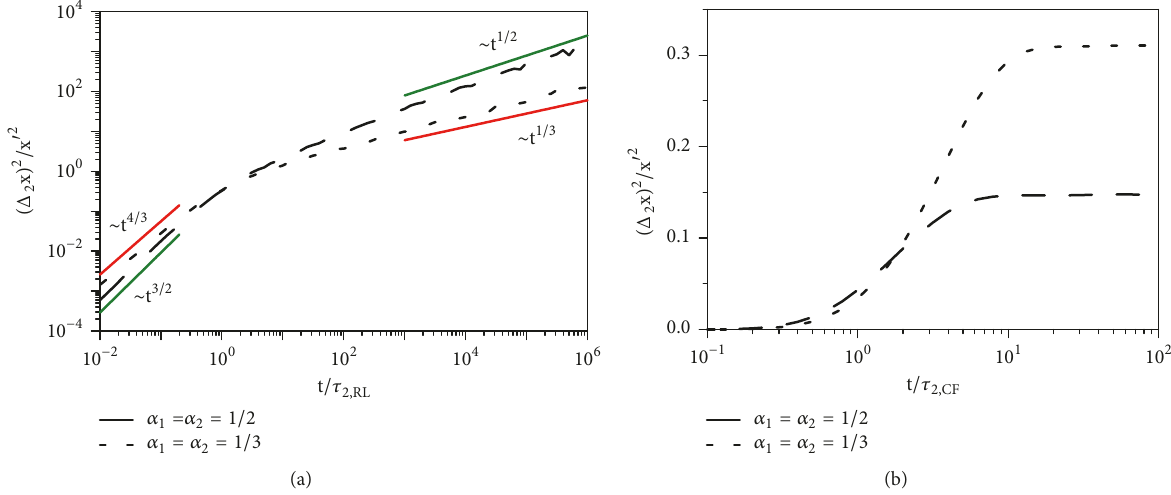
Figure 8: (a) illustrates the mean square displacement for species 2 for different values of 𝛼 1(2) by taking into account the Riemann-Liouville fractionaltimeoperator.Weconsider,forsimplicity, 𝜏 1(2),𝑅𝐿 = (𝑥 󸀠2 / K 1(2) ) 1/𝛼 1(2) ,and 𝑘𝜏 1,𝐶𝐹 /𝑥 󸀠 = 1 , 𝜑 1 (𝑥) = 𝛿(𝑥−𝑥 󸀠 ) , 𝜑 2 (𝑥) = 0 ,and 𝜏 1(2),𝑅𝐿 = 1 , in arbitrary unities. (b) illustrates the mean square displacement for species 2 for different values of 𝛼 1(2) for species 2 by taking into account the Caputo-Fabrizio fractional time operator. We consider, for simplicity, 𝜏 1(2),𝐶𝐹 = √𝑥 󸀠2 /𝐷 1(2) , and 𝑘𝜏 1,𝐶𝐹 /𝑥 󸀠 = 1 , 𝜑 1 (𝑥) = 𝛿(𝑥−𝑥 󸀠 ) , 𝜑 2 (𝑥) = 0 , and 𝜏 1(2),𝐶𝐹 = 1 , in arbitrary